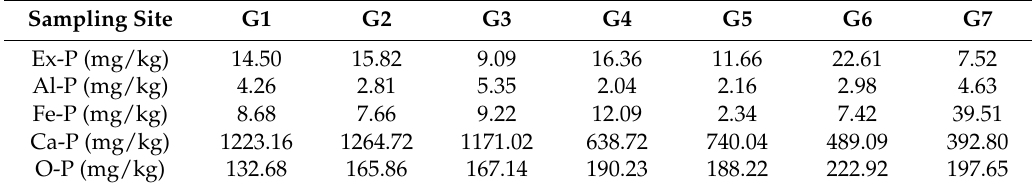
Table 2. The contents of different forms of inorganic phosphorous (IP) at each sampling site.